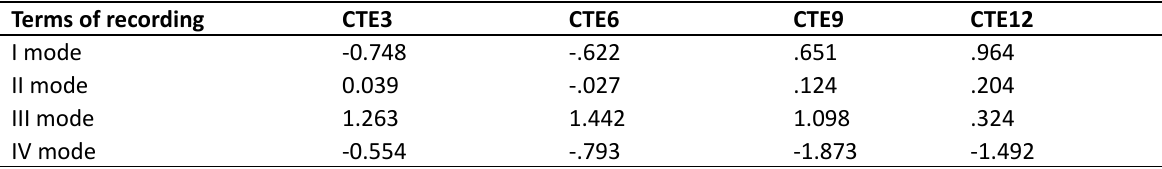
Table 6. Functions at group centroids. Boys aged 8